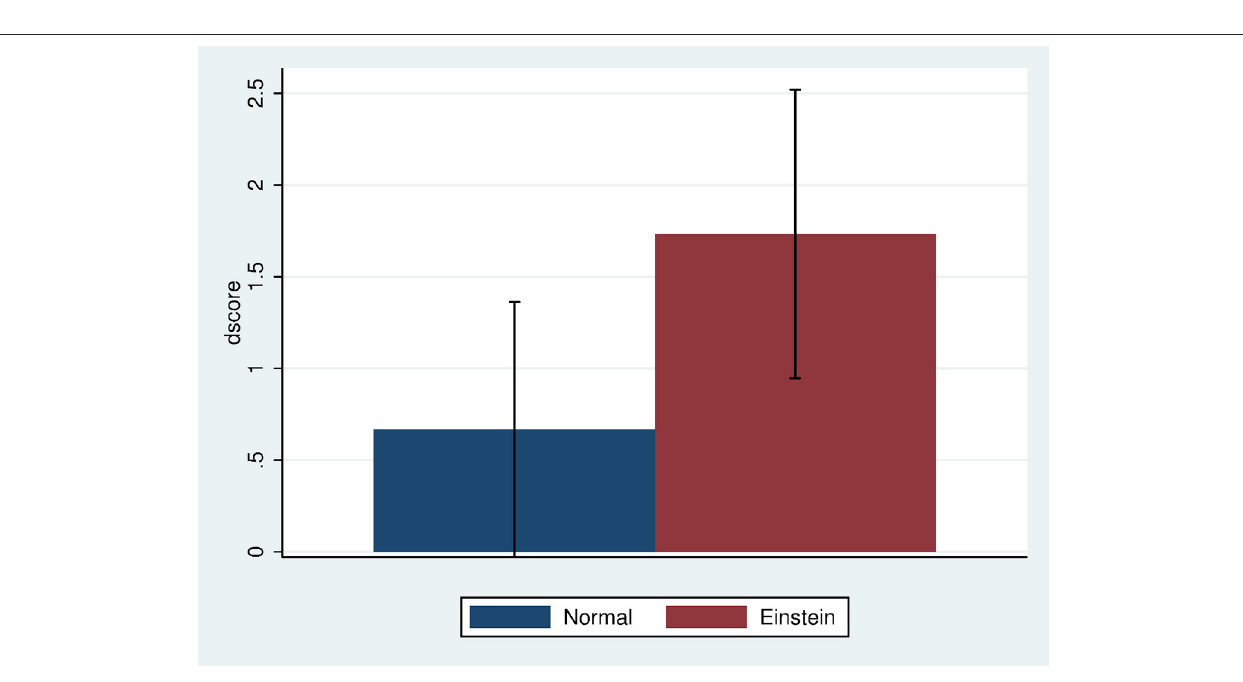
findings on racial bias reported in Peck et al. (2013) and Banakou et al. (2016), where we found that embodiment of “White” people in a dark-skinned body reduces but does not flip implicit racial